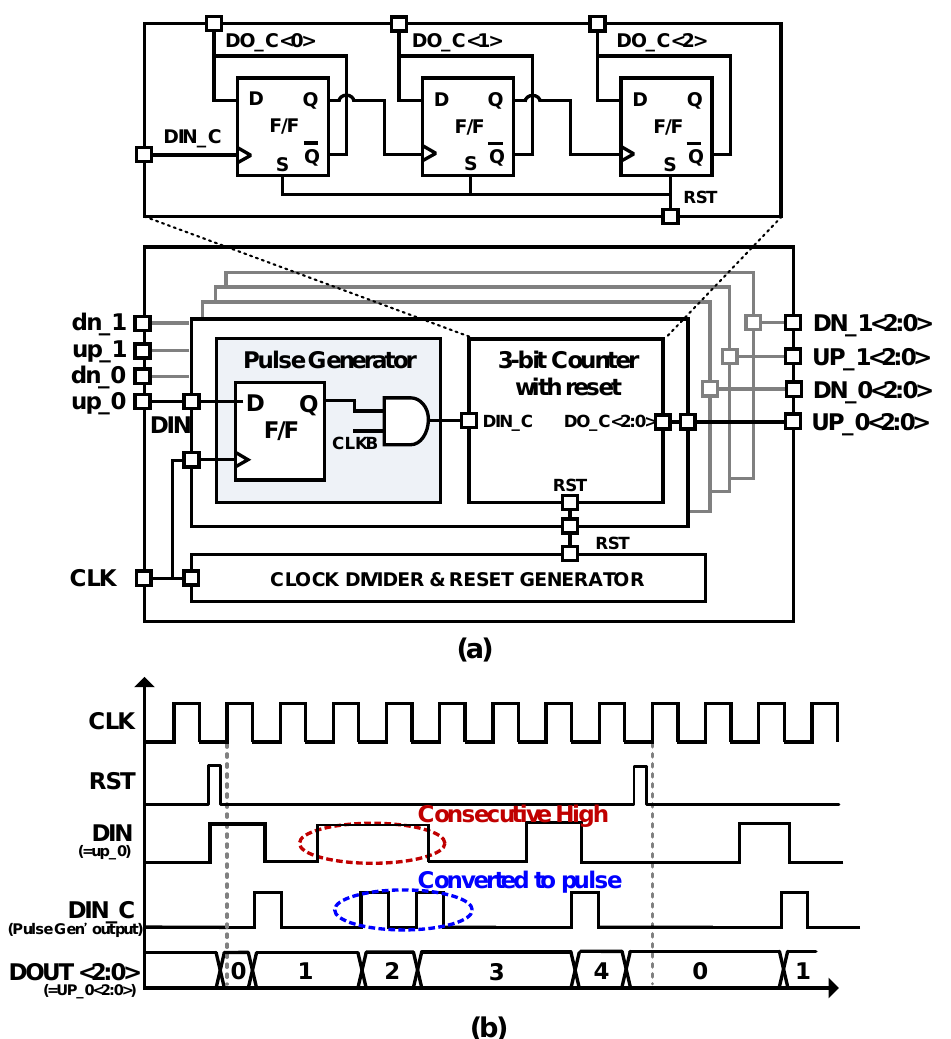
Figure 9. ( a ) Proposed decimator scheme, ( b ) the operation behaviors of the proposed decimator.